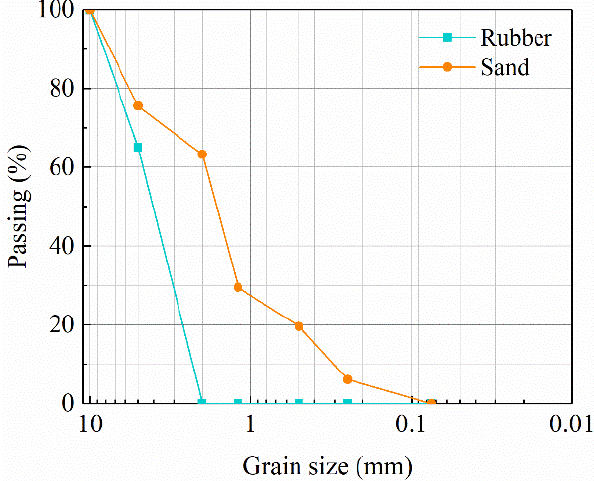
Figure 9. Cumulative gradation curve.